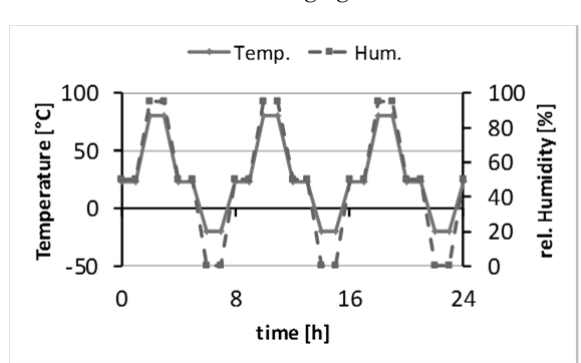
Fig. 26 Temperature cycling from -20 °C up to +80 °C at 95 % r. H.